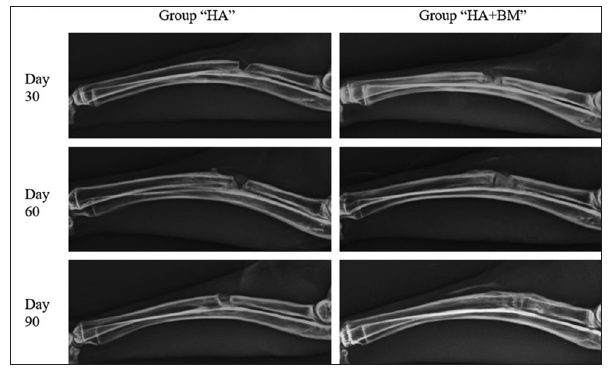
Figure-2: Mediolateral radiographs of animals in “hydroxyapatite (HA)” and “HA+bone marrow (BM)” groups, on day 30, 60, and 90 showing a defect still present in “HA” group and completely filled in “HA+BM” group on day